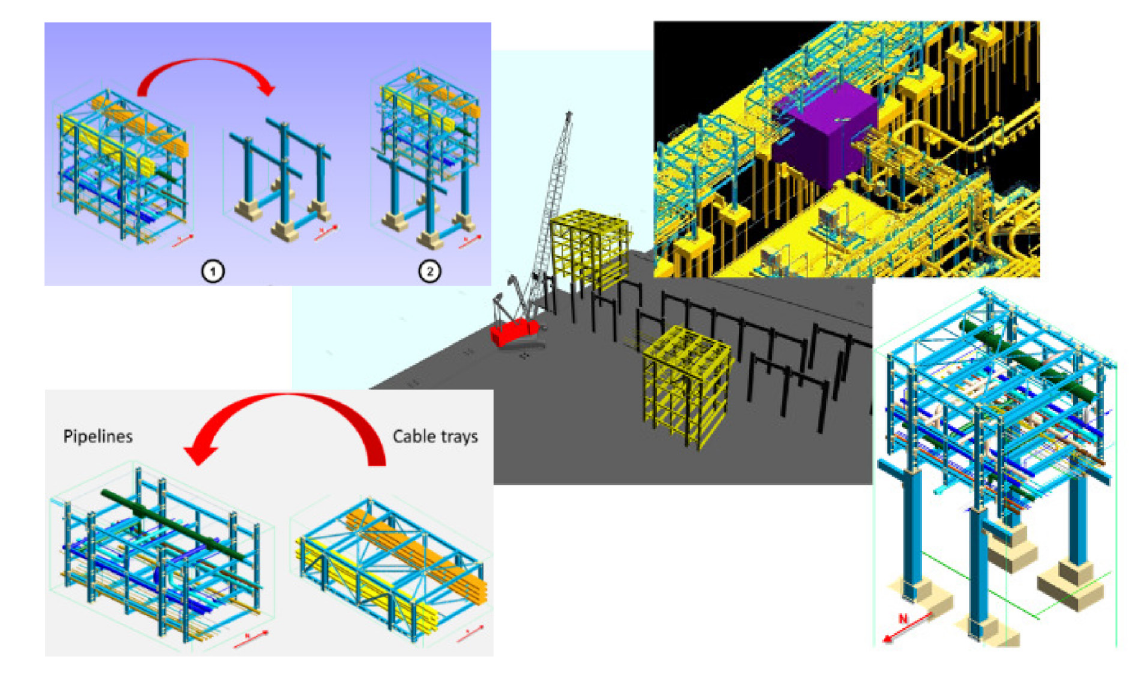
Fig. 3. Rapid generation and evaluation of construction plans